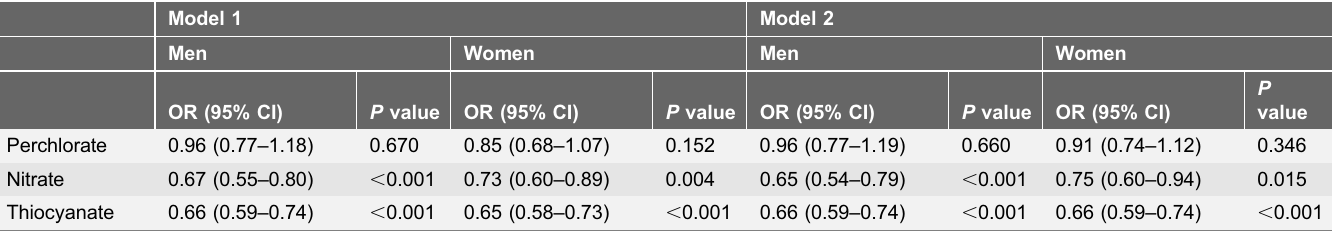
Table 5. Adjusted odds ratios (ORs) with 95% confidence intervals (95% CIs) for hyperparathyroidism (defined as parathyroid hormone . 70 pg/mL) by creatinine-corrected urinary concentrations of perchlorate, nitrate, and thiocyanate among the United States adults, NHANES